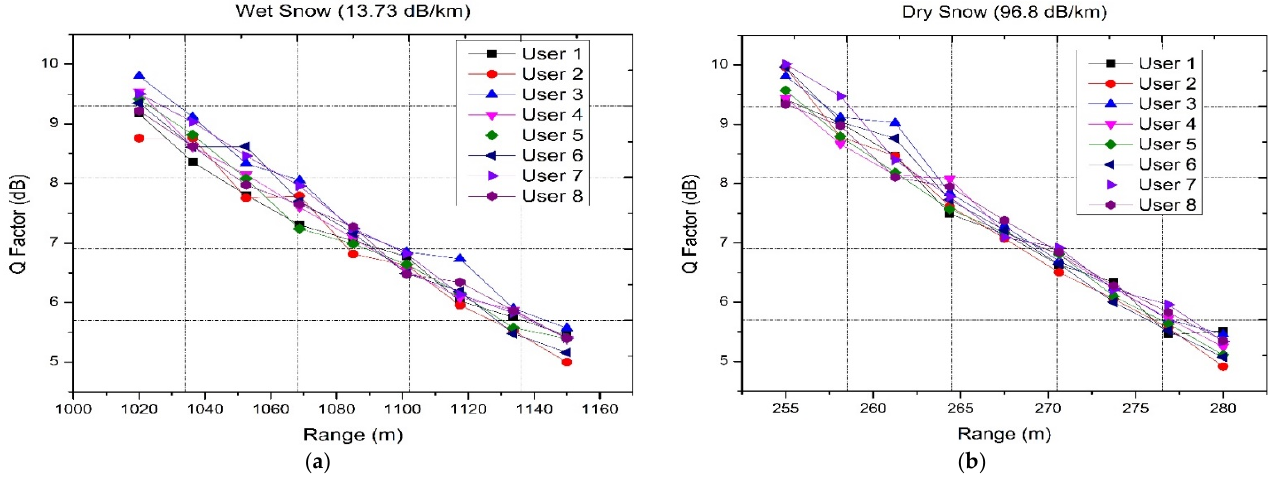
Figure 13. Q-factor of FSO-PDM/PV-OCDMA system versus FSO link under ( a ) DS, and ( b ) WS. Table 6. Log (BER) values and Q-factors of eight channels of FSO-PDM/PV-OCDMA system under different snowfall and propagation ranges.